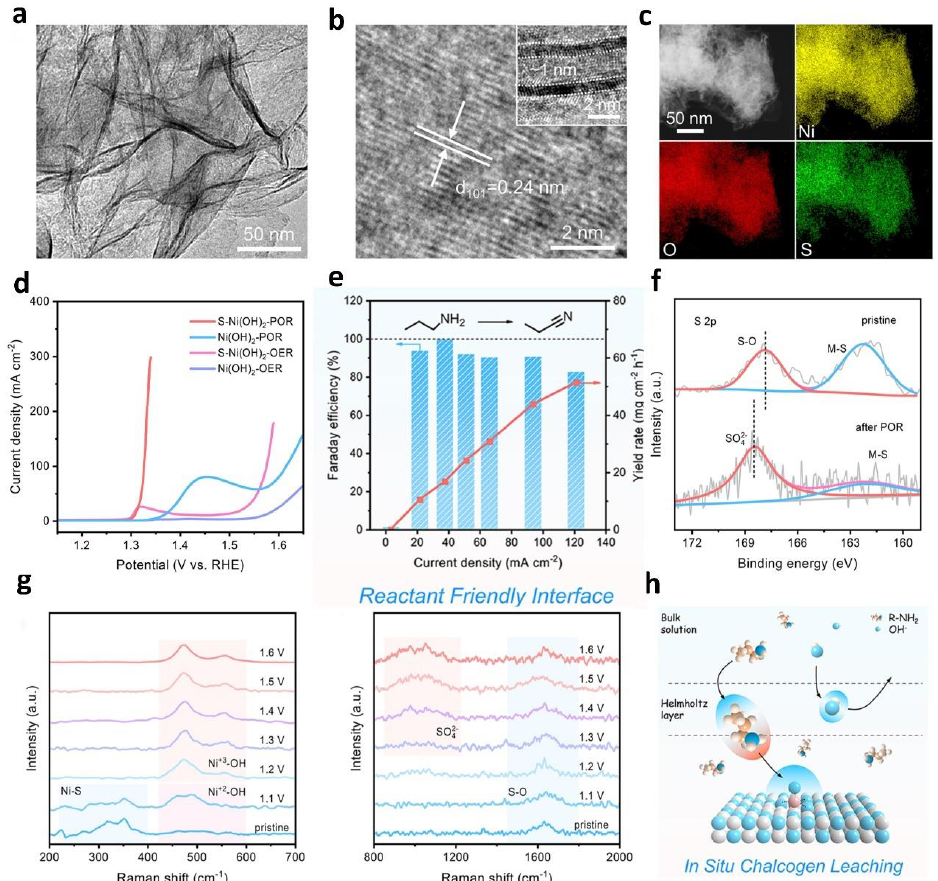
Figure 5. ( a , b ) Transmission Electron Microscope (TEM) and high-resolution TEM images of the catalyst. ( c ) High−Angle Annular Dark Field−Scan Transmission Electron Microscope (HAAD−STEM) image and Energy Dispersive X−ray Spectroscopy (EDX) element mapping. ( d ) Linear sweep voltammetry curves and ( e ) FE and production rate under different current density of the targeted propionitrile. ( f ) X−ray Photoelectron Spectra (XPS) S 2p spectra of S−Ni(OH) 2 and ( g ) in situ Raman spectra of S−Ni(OH) 2 . ( h ) Schematic illustration of manipulating the reactant interface toward efficient amine electrooxidation [84]. Copyright 2022, American Chemical Society (ACS) Publishing Group.